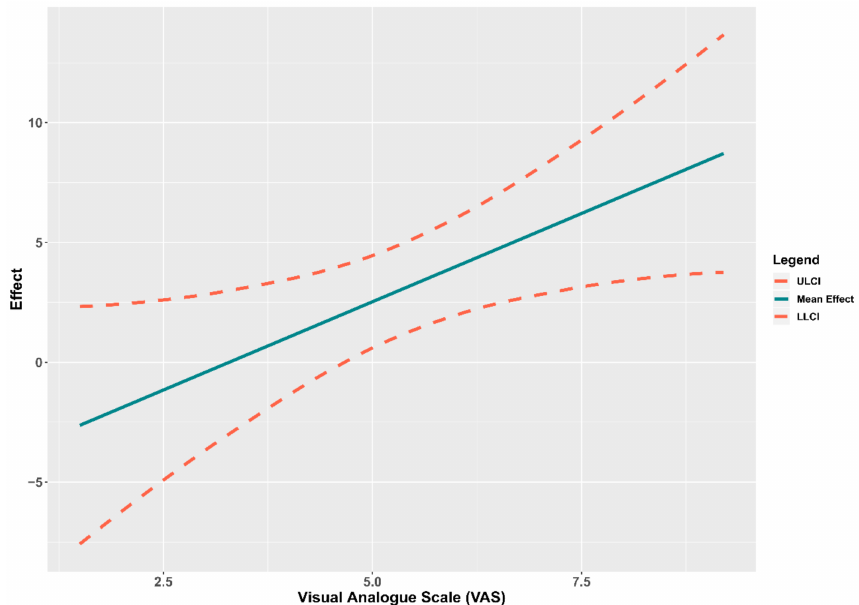
Figure 2. Conditional effect of the pressure pain threshold measured at C2 over the cranio-cervical angle depending on the level of the visual analogue scale. Abbreviations: ULCI, upper limit of the 95% confidence interval; LLCI, lower limit of the 95% confidence